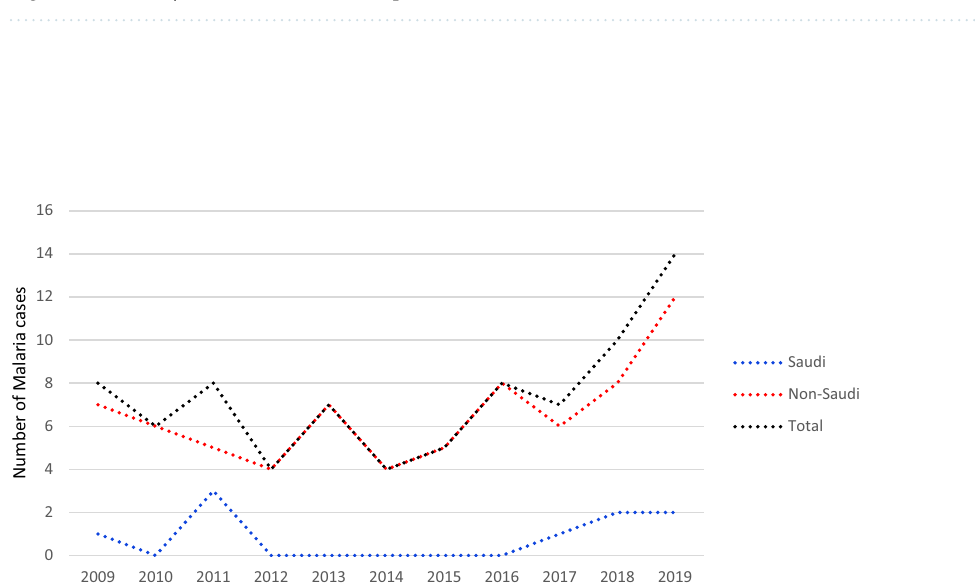
Figure 2. Annual distribution of malaria positive